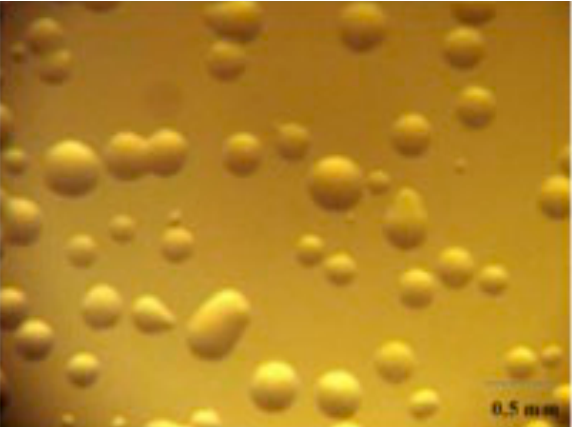
Figure 4. Colony morphology of a Xylella fastidiosa strain isolated from grapevine on PD3 agar medium after incu- bation at 28 o C for 10 d. Scale bar = 0.5